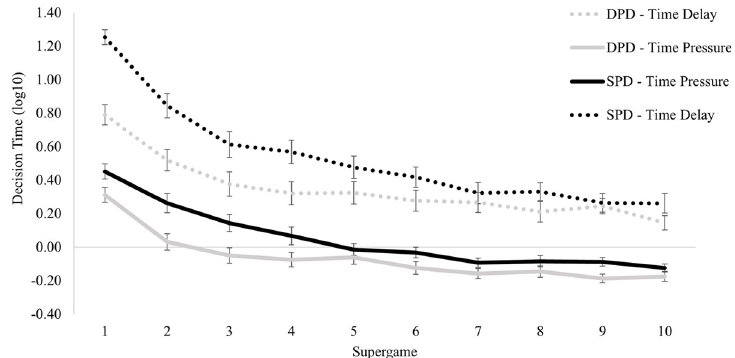
Fig 6. The average amount of decision time across conditions and rounds played. n = 28 participants in each condition presented. Error bars indicate standard errors of the mean.